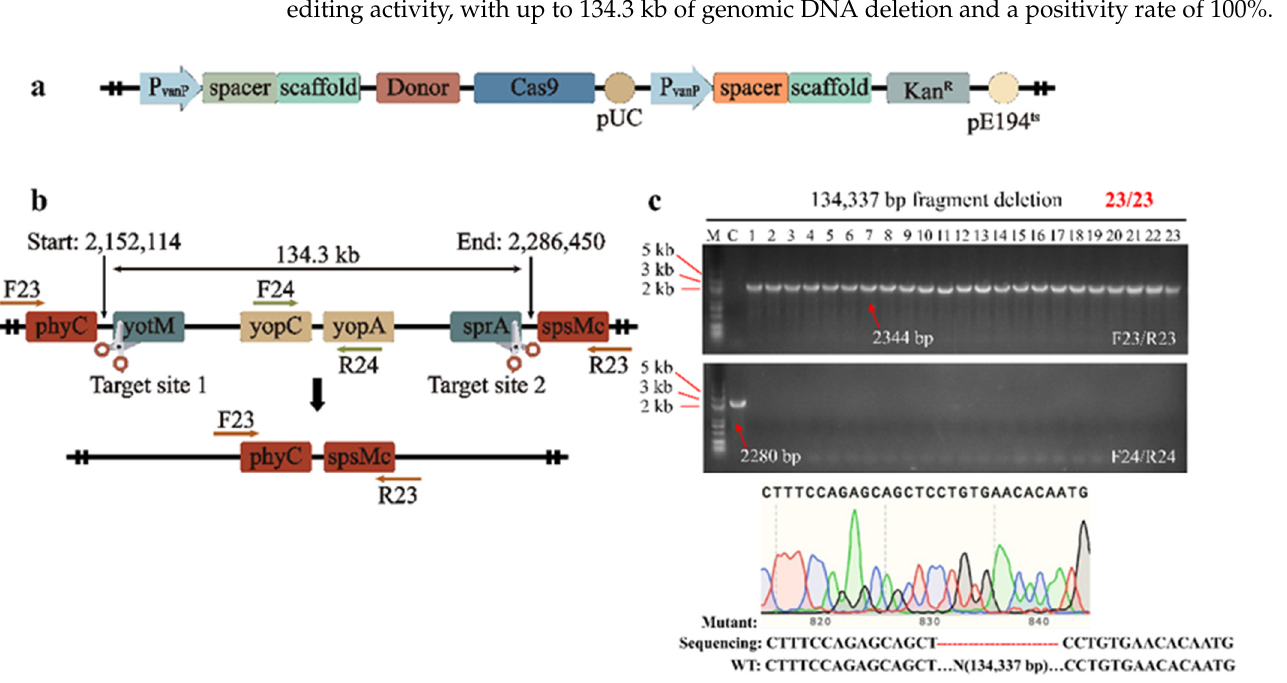
Figure 2. The genomic positions and positivity rates of long fragment deletions ( a ) Position of each deleted long fragment in the genome. ( b ) Positivity rate statistics of each long fragment deletion. ( c ) Morphological comparison of the wild-type strain (WT) and long fragment deletion strains. All strains were Gram-stained and observed using light microscopy.